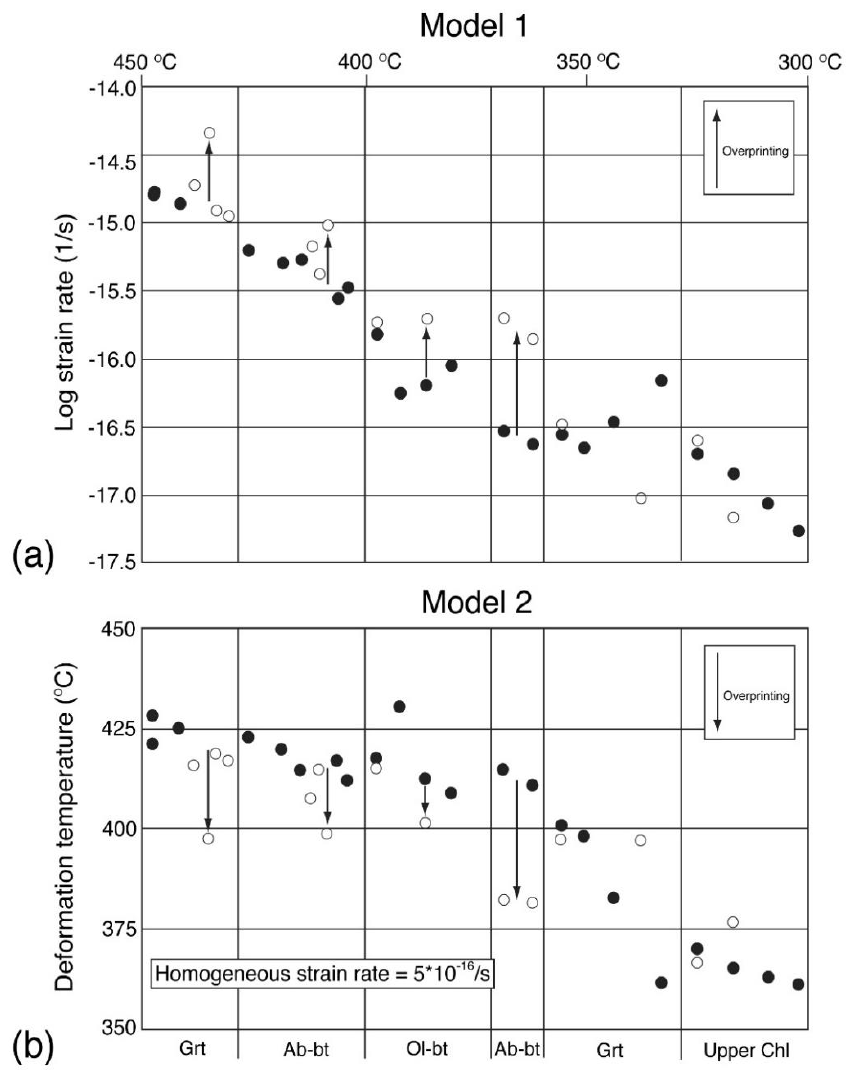
Figure 7. Plot of the calculated ( a ) strain rate (log 𝜀̇ ) and ( b ) deformation temperature ( T ) along the Asemi-Saruta-Dozan River traverse, using the constitutive equation after [75], where the physical constant A , n , and E (see text) are 1.1 × 10 − 4 [MP − n s − 1 ], 4.0, and 223 [kJ mol − 1 ], respectively. In ( a ), deformation temperatures are assumed (model 1), as shown on the top horizontal line, while in ( b ), a constant strain rate of 5 × 10 − 16 [s − 1 ] is assumed (model 2). See the captions of Figure 3a and text for explanations. Additionally, see text for abbreviations of each of the peak-metamorphic zones.